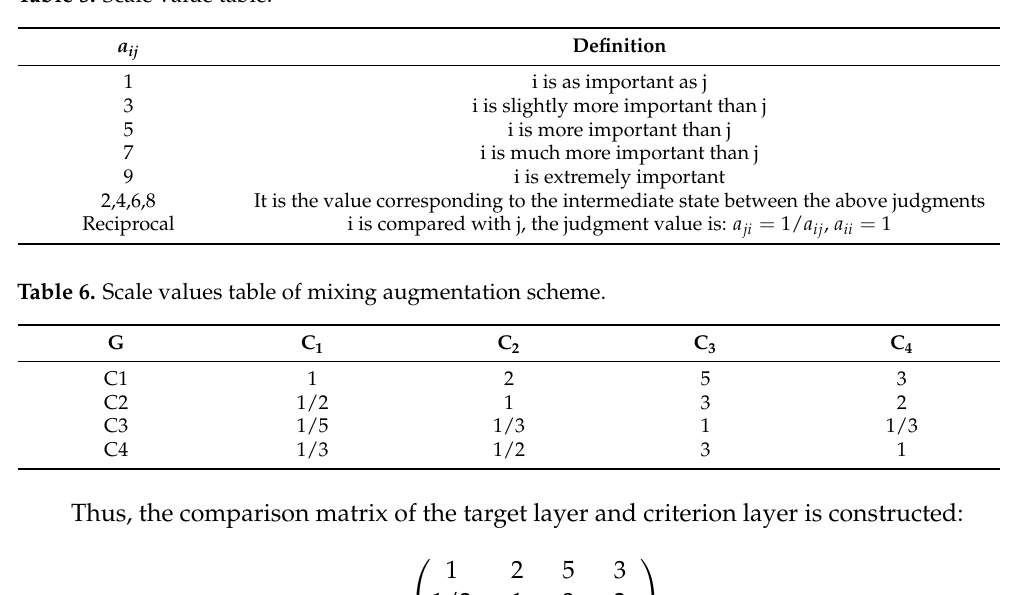
Figure 20. The diagram of the hierarchical structure. Table 5. Scale value table.